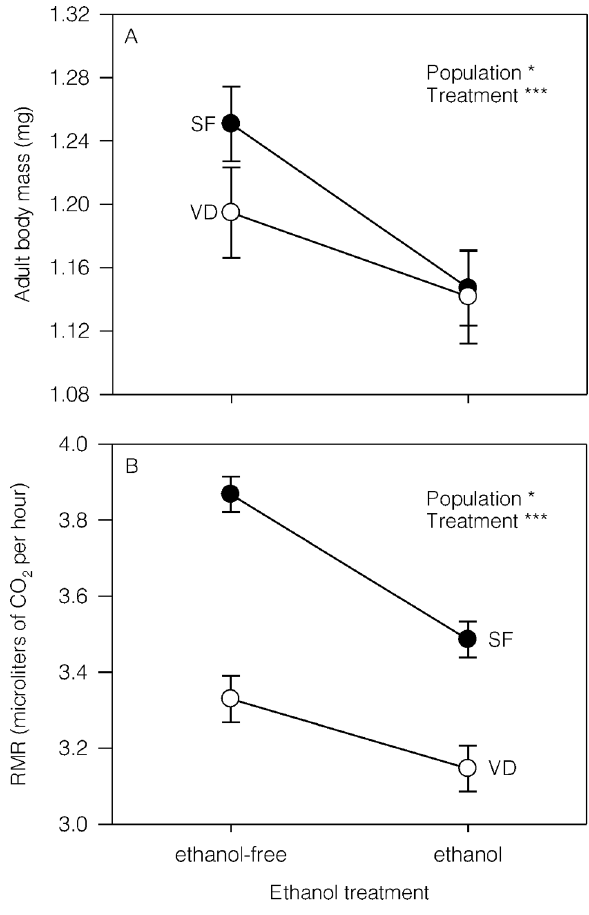
Figure 2. Reaction norms of body mass and metabolic rate for Drosophilamelanogaster flies developed in contrasting ethanol conditions. Average ( 6 SE) adult body size (A) and routine metabolic rate (RMR; B) for flies (sexes were pooled) from the San Fernando (SF) and the Valdivia (VD) populations reared in ethanol-free (0% ethanol) and ethanol-supplemented (7% ethanol) conditions. Significant effects are expressed as: * P , 0.05, ** P , 0.01, *** P , 0.001.